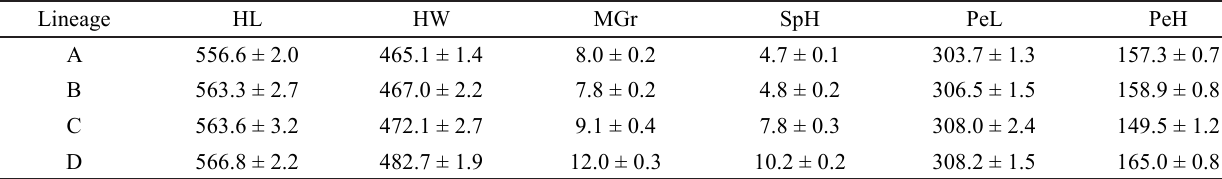
Table 2. Metric traits (mean ± SE, μm ) of six measured parts (Fig 1) obtained from the four mtDNA lineages (A, B, C and D) of Cardio- condyla sl. kagutsuchi workers in Japan. HL, HW, MGr, SpH, PeL and PeH designate the head length, head width, depth of the metanotal groove, height of the propodeal spine, petiole length and petiole height, respectively.